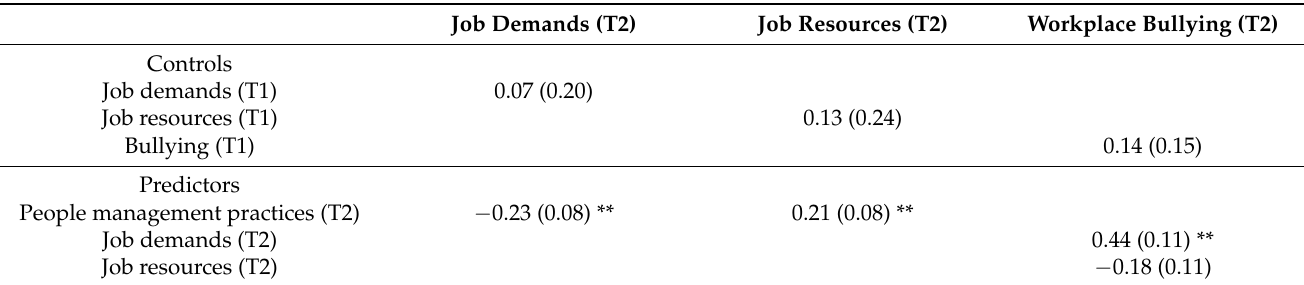
Table 4. Mediation results at the department